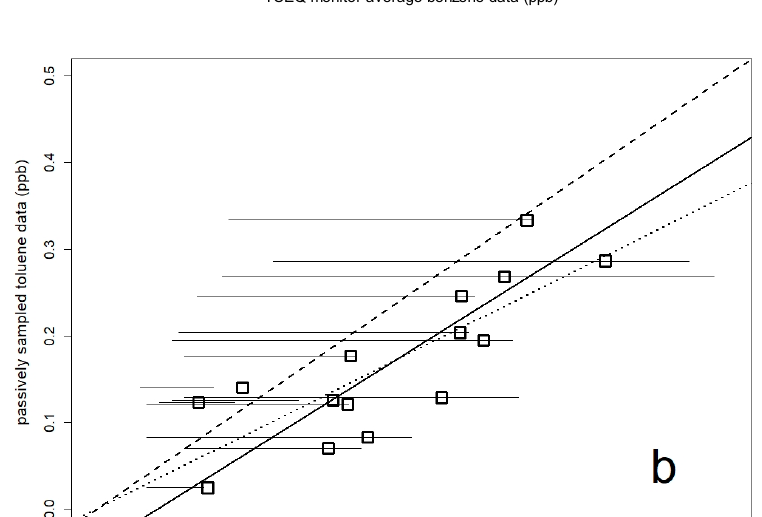
Figure 4. Regression plots of passively sampled benzene ( a ) and toluene ( b ) against average air quality monitoring data. Dashed lines represent the ideal 1:1 relation, and solid lines the major axis regression result. Horizontal bars represent the hourly air monitoring data interquartile ranges; the dotted line in ( b ) is the result of an OLS regression forced through the